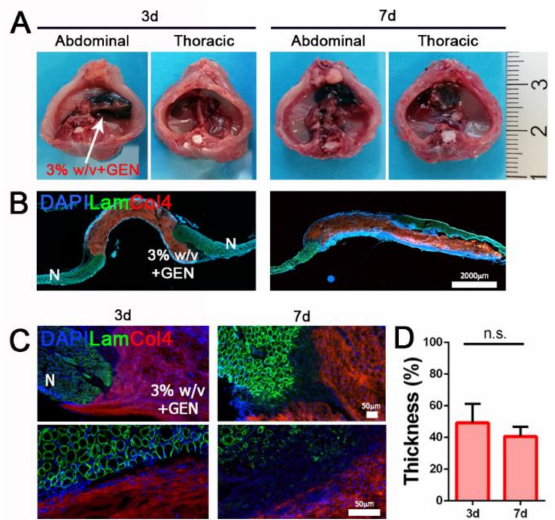
Figure 5. Diaphragm dECM-derived hydrogel in vivo implantation. ( A ) Gross appearance of abdominal and thoracic sides of treated diaphragms after 3 and 7 days. ( B ) Representative images of transversal section of treated diaphragms after 3 and 7 days. ( C ) Immunofluorescence staining for the detection of Laminin and Col4. ( D ) Thickness of 3% w/v + GEN hydrogel after in vivo implantation expressed as percentage of the initial thickness (100%). N: native muscle. n.s.: